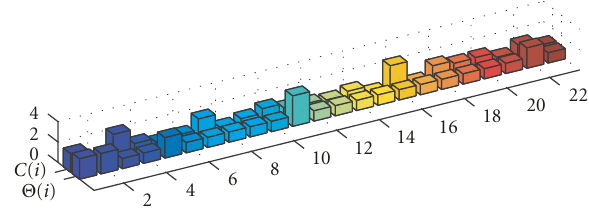
Figure 7: An example of row layout Θ ( i ) generated by the DP algo- rithm, compared to the cost function C ( i ).